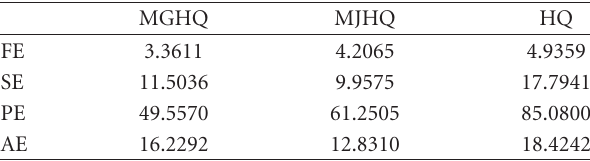
Table 1: Weights of extracts of MGHQ, MJHQ and HQ